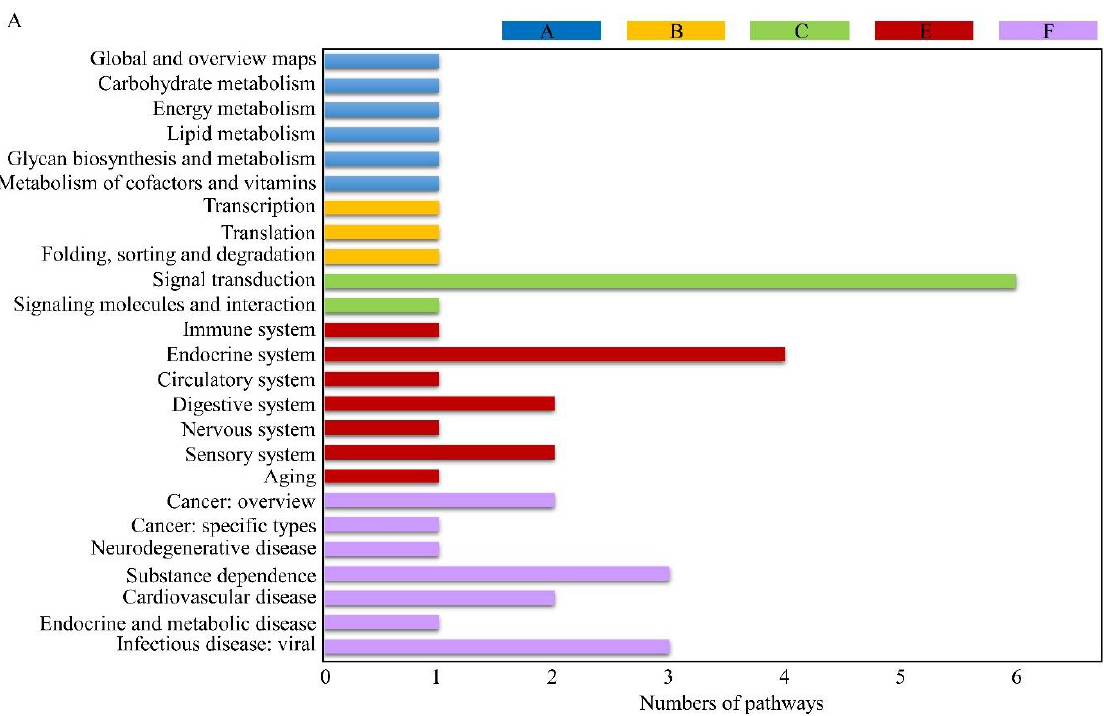
Figure 3. KEGG (Kyoto Encyclopedia of Genes and Genomes) assembled unigenes from chlorophyl- lides composites treatments. ( A ) MCF-7 cells; ( B ) MDA-MB-231 cells. The results were classified into six categories: A. metabolism; B. genetic information processing; C. environmental information pro- cessing; D. cellular processes; E. organismal systems; and F. human diseases. The y -axis is classifi- cation of KEGG, and the x -axis is the corresponding numbers of pathways. p < 0.5. 3.4. Analysis of Common KEGG Pathways To further identify the chlorophyllides composites relevant KEGG pathways that were common in both breast cancer cell lines, we compared the KEGG pathways that were